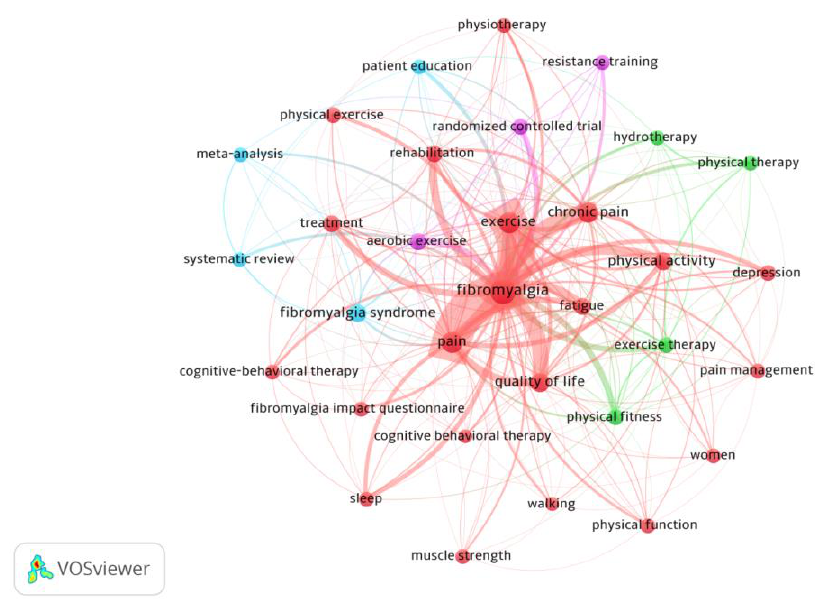
Figure 7. Citations per article on fibromyalgia and physical activity.